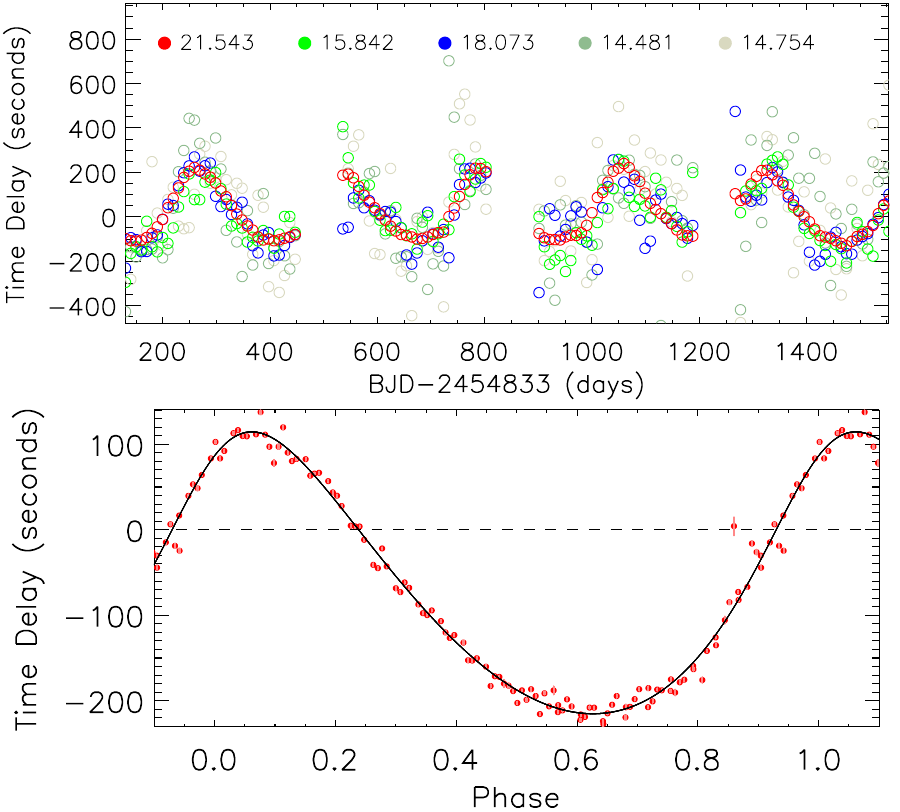
Figure 3. Time delay analysis of KIC 5080290. Top : Time delay curves of the pulsation modes. Legends of different colors represent different pulsation frequencies, arranged from left to right by amplitude. Red color represents the strongest pulsation. Bottom : Phased time delay curve of the strongest pulsation. The red points with error bars are the time delay data. The black line is the fitting